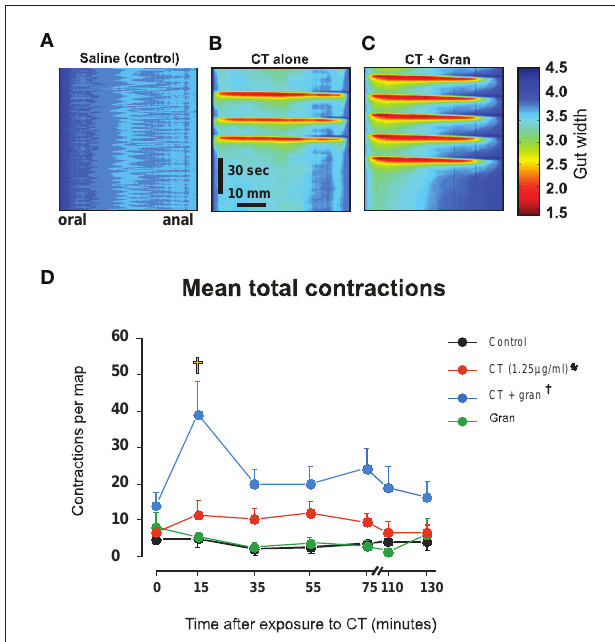
Figure 1 | Motor activity induced by luminal CT. (A–C) Spatiotemporal maps made during the 5–25 min after exposure to saline, 1.25 μg/ml CT and 1.25 μg/ml CT plus 1 μM granisetron, respectively. Each map shows 2 min of recording. (B,C) were selected to show bursts of propulsive contractions. (D) Mean numbers of contractions vs time for luminal saline (black), CT (1.25 μg/ ml, red), granisetron (1 μM, gran, green), CT plus granisetron (CT + gran, blue). Whole curve differs from saline control (* P < 0.0005), whole curve differs from CT alone († P < 0.0001), differs from control and CT alone (‡ P < 0.001).